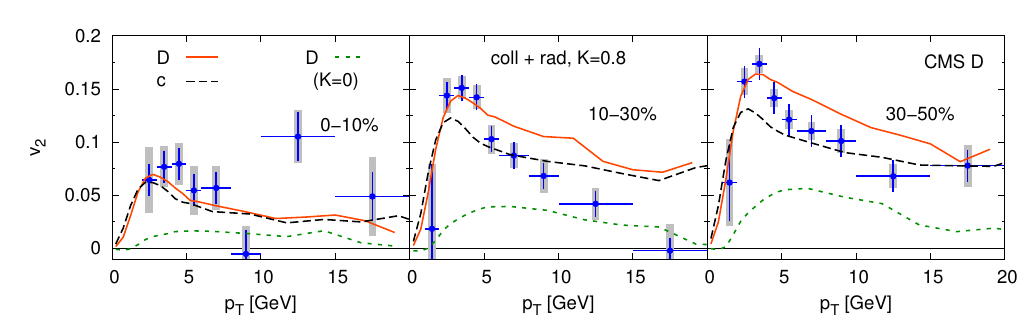
Figure 3. Same as Fig. 1 but for the collisional + radiative energy loss mechanism with K = 0 . 8.